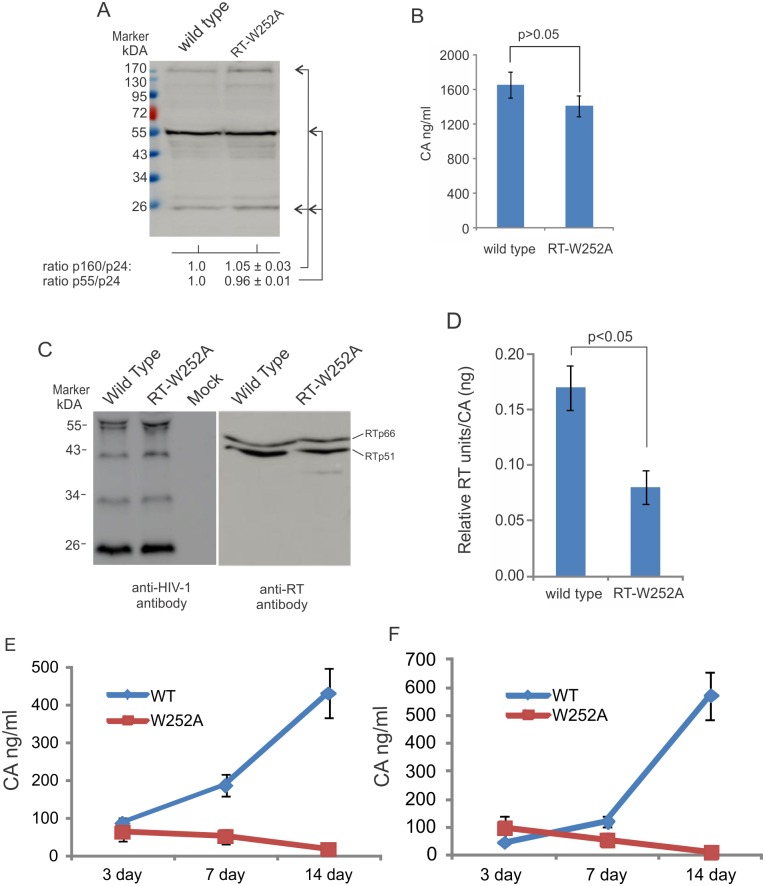
A W252A RT mutation inhibits HIV-1 reverse transcription and replication.(A) Proviral plasmids transiently expressing wild type or W252A RT mutant HIV-1 in HEK293T cells were visualized by western blot using a rabbit anit-HIV-1 antibody. Western blot samples were normalized for transfection efficiency using a co-transfected Gaussia luciferase reporter plasmid. (B) The amount of virus present in culture supernatant was measured using a CA ELISA. Results are normalized for transfection efficiency as determined by secreted Gaussia luciferase. (C) Western blot of concentrated HIV-1 virus particles from culture supernatants expressing wild type or W252A RT HIV-1, detecting with anti-HIV-1 (left, human serum, NIH AIDS reagent) or anti-RT antibodies (right). (D) The RT activities of wild type and W252A RT mutated viruses were measured using a standard RT colorimetric assay and normalized to CA levels in each sample. (E) Jurkat cells were infected with wild type or W252A RT mutant virus using equivalent amount of CA (500 ng CA/107 cells) or (F) equivalent amount of RT (5 ng of RT/107 cells). Virus replication was monitored by using an ELISA to measure CA in the culture supernatant at 0, 3, 7 and 14 days post-infection. The mean values and standard deviations from an experiment performed in triplicate are shown. The experiment was repeated twice with similar results.